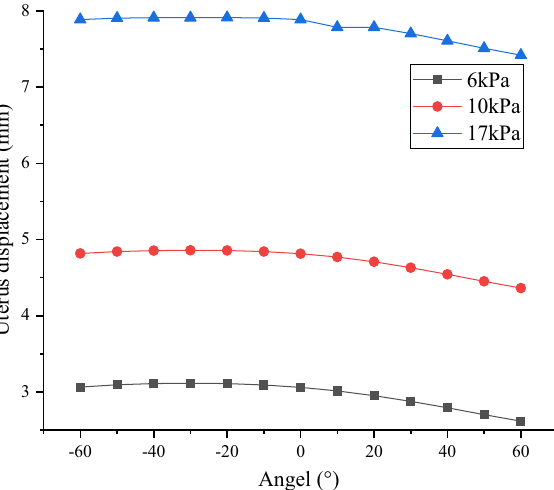
Figure 5. Changes of uterine displacement in different postures (created by OriginPro 2021, https:// www. origi nlab. com/).